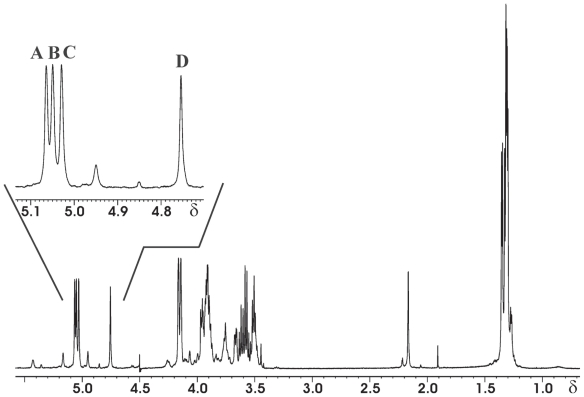
1H NMR spectrum of the capsular polysaccharide isolated from Burkholderia gladioli pv. agaricicola.